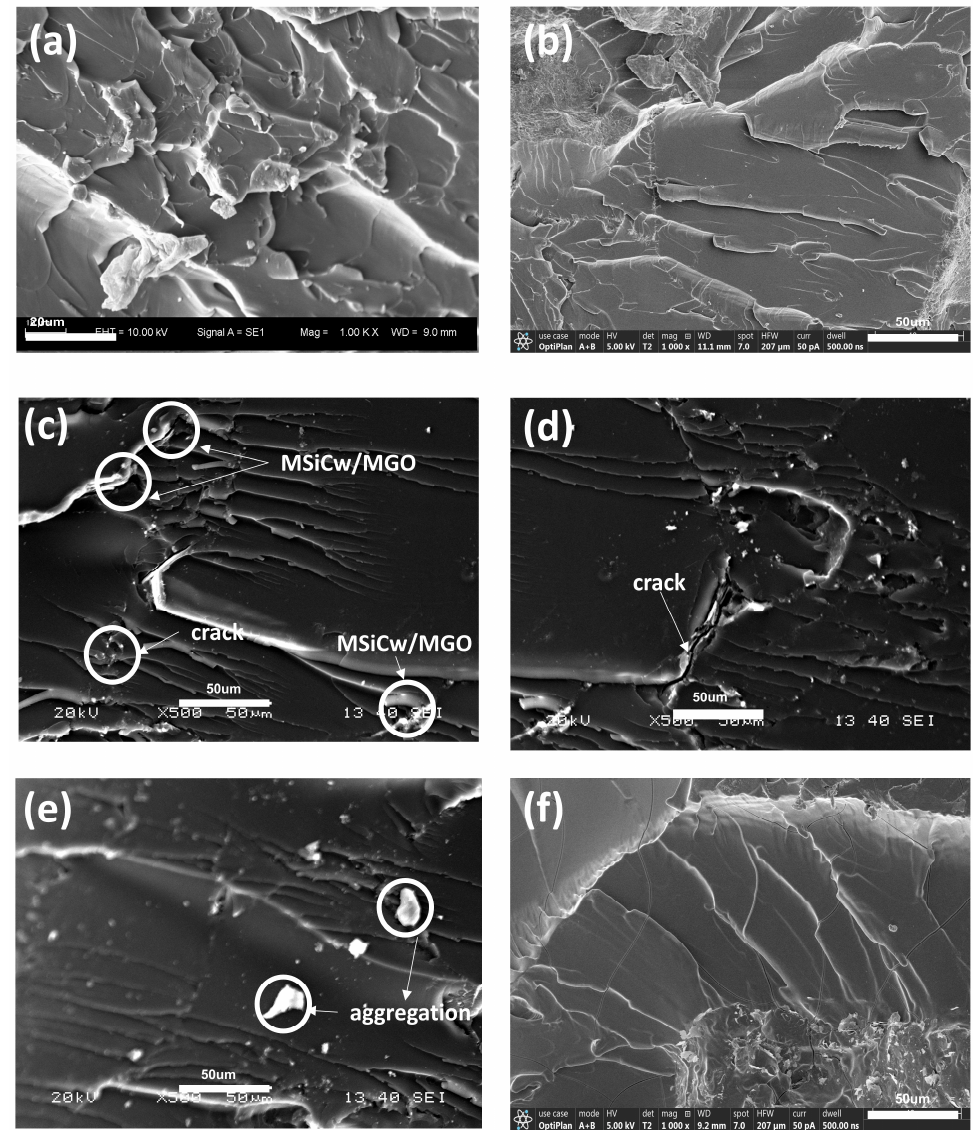
Figure 6. SEM images of impact fracture surfaces of PI ( a ), SiCw-1-PI ( b ), MSiCw-1-MGO- 0.2-PI ( c ), MSiCw-1-MGO-0.3-PI ( d ), MSiCw-1-MGO-0.5-PI ( e ), GO-0.3-PI ( f ). MSiCw-1-MGO-0.3-PI ( d ), MSiCw-1-MGO-0.5-PI ( e ), GO-0.3-PI ( f